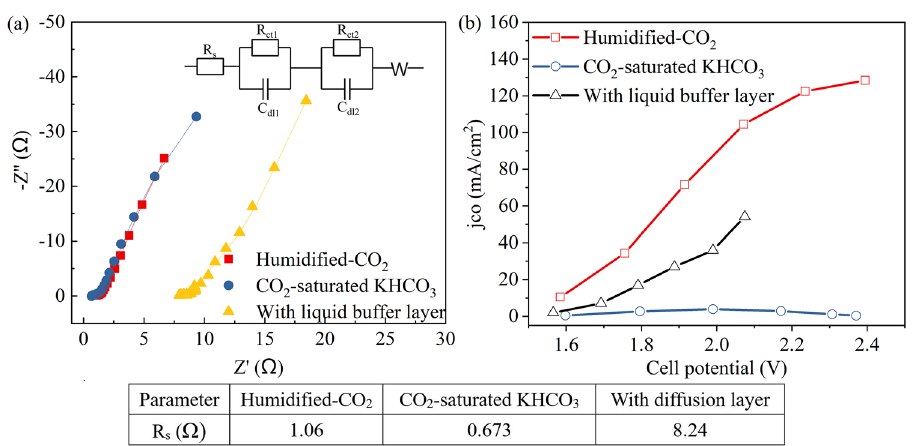
Figure 3. (a) EIS results and the relevant equivalent circuits acquired with different cathode feeding methods or configurations under open-circuit level. Points and lines represent measured and fitted results, respectively. (b) j CO as a function of the cell potential (after iR